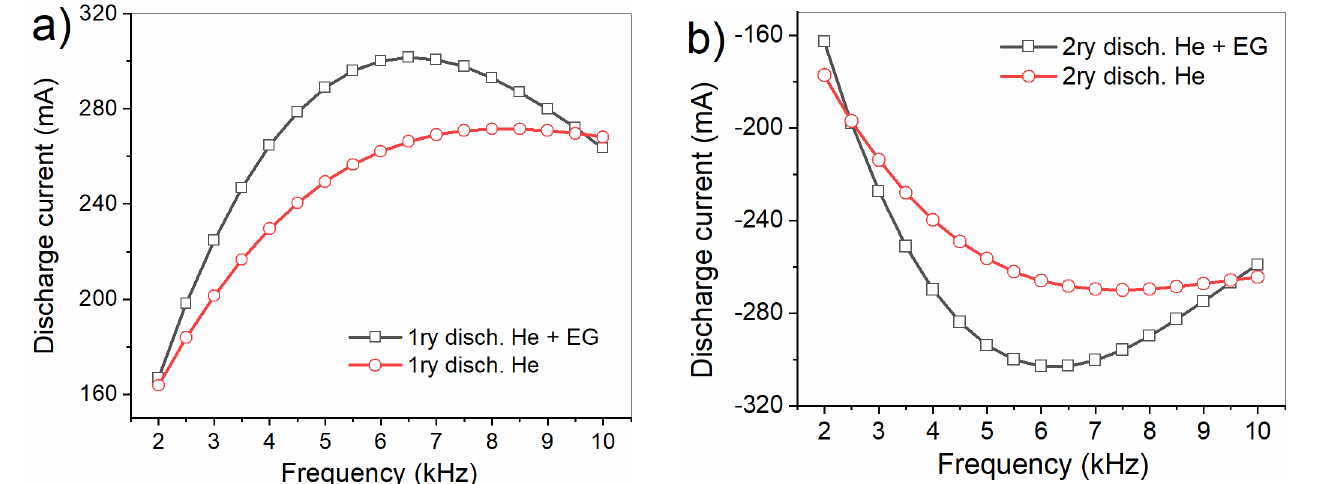
Figure 3. Variation with frequency of the current intensity peak of the 1ry ( a ) and 2ry ( b ) discharge in He and He with ethylene glycol (EG)